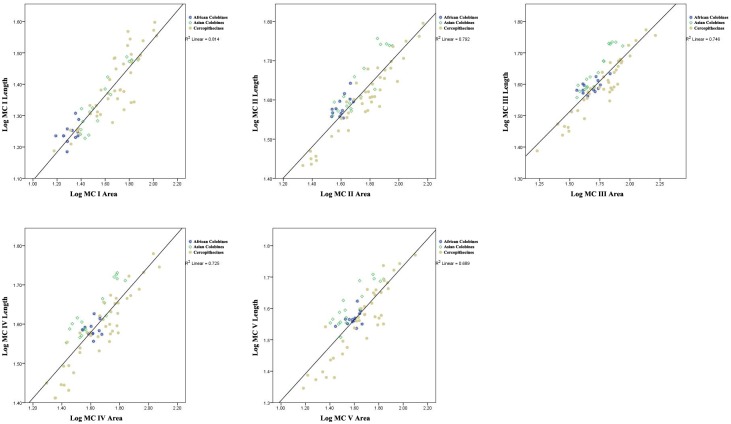
Bivariate plots showing correlation between metacarpal basal area and length transformed as logarithms.